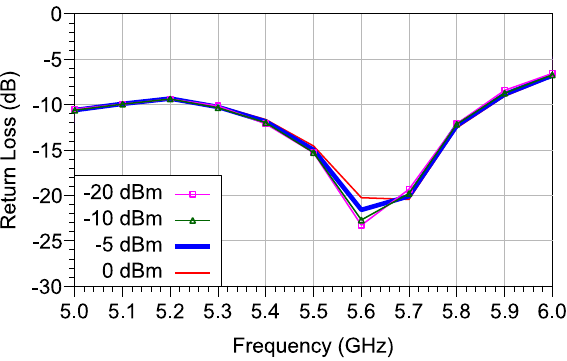
Figure 11. Measurement results of the return loss of the detector for different input power levels. Red solid line is 0 dBm, blue thick line is − 5 dBm, green reverse triangle line is − 10 dBm, violet square line is − 20 dBm.